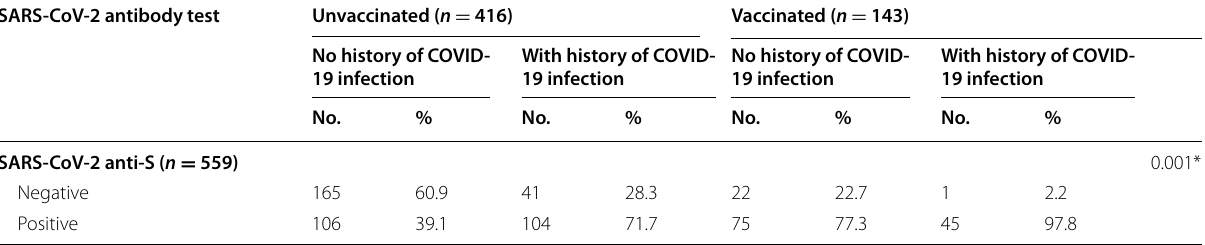
P exact probability test *p < 0.05